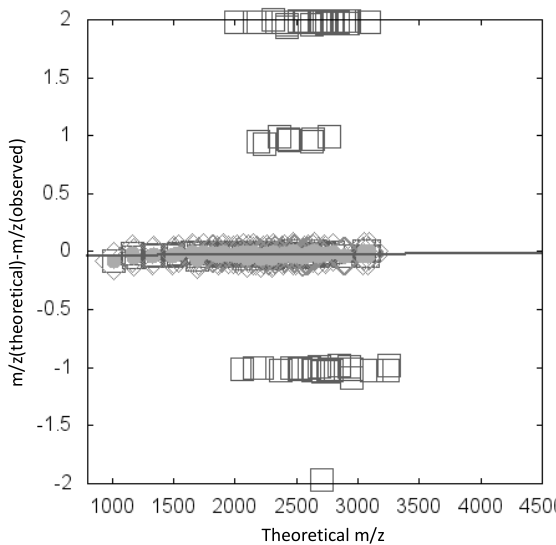
Figure 4. Example of a scatter diagram in which the x-axis is m / z (theoretical) and the y-axis is the deviation between theoretical and observed m / z values. Diamonds indicate the maximum cluster. Data are fitted to a linear function, and line indicates the fit. Gray circles indicate annotated glycan data points within a certain distance from the fitted